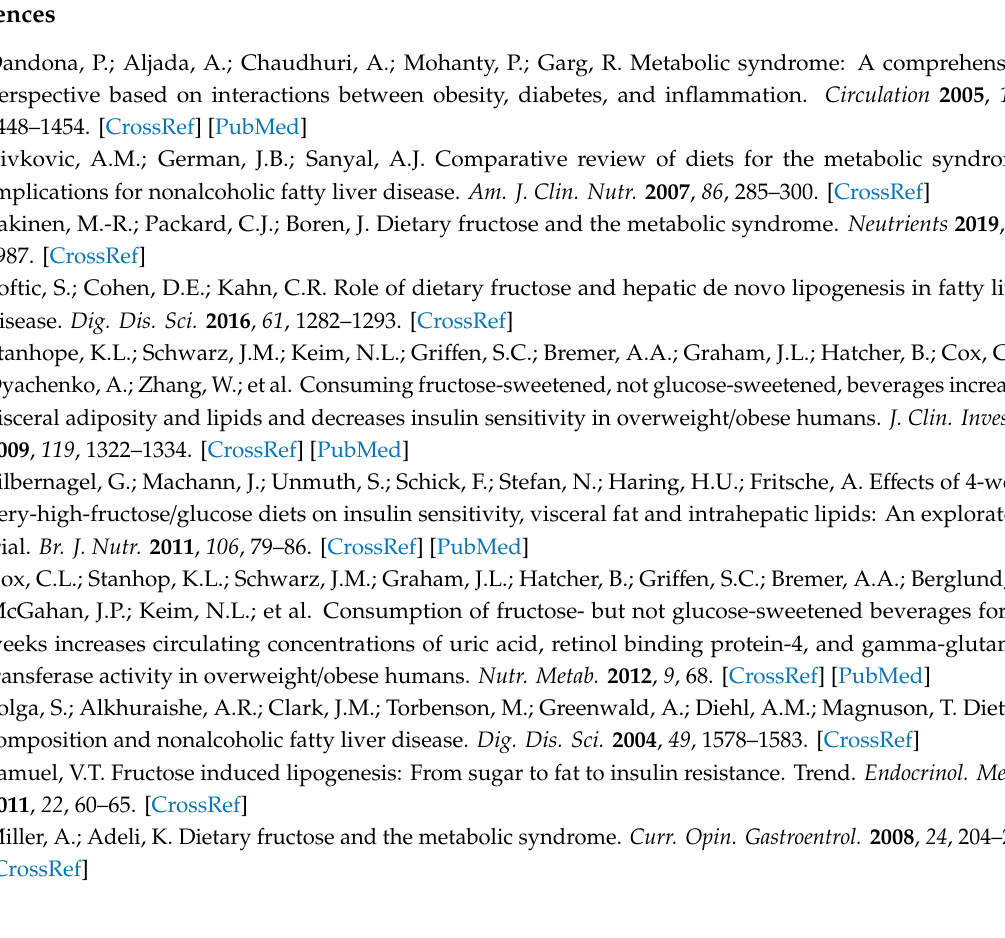
Figure S1. HPLC-PDA chromatogram of SQE, Table S1. Composition of experimental diets (g / kg), Table S2. List of di ff erentially expressed genes (DEGs) in SQE group vs. high fructose (HF) diet